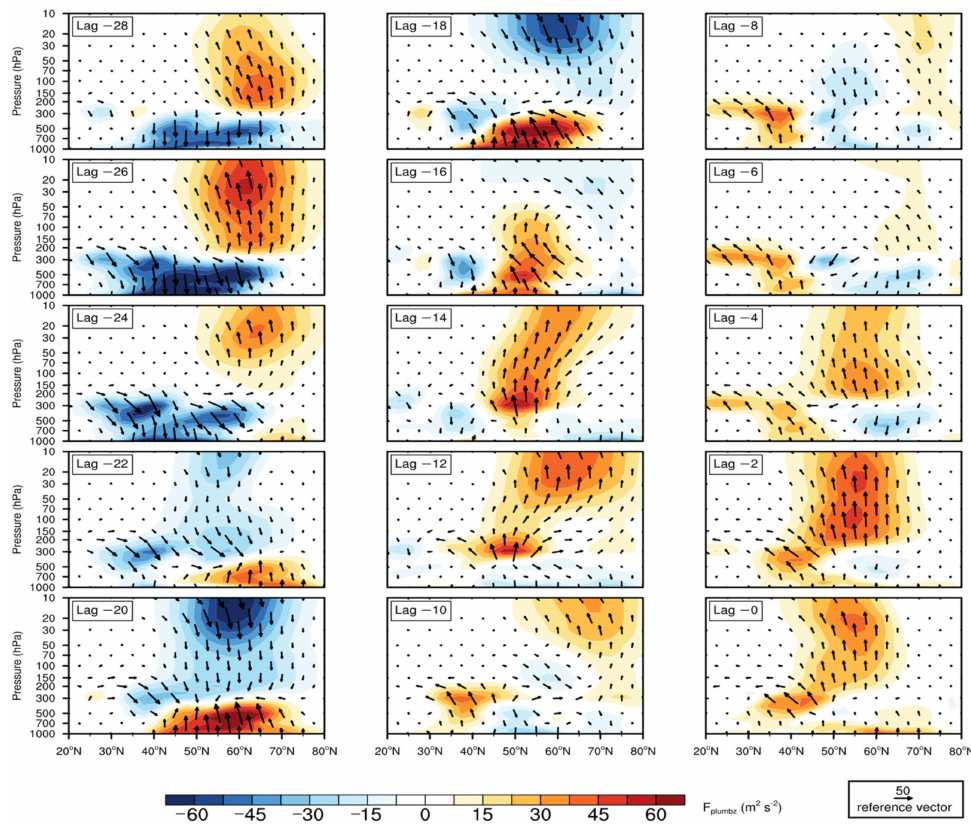
Figure 13. Latitude–pressure cross sections of Plumb wave activity flux (vertors; unit: m 2 s − 2 ), where shadings indicate the vertical component of Plumb wave activity flux (unit: m 2 s − 2 ) along 20 ◦ –140 ◦ E from Lag − 28 to Lag